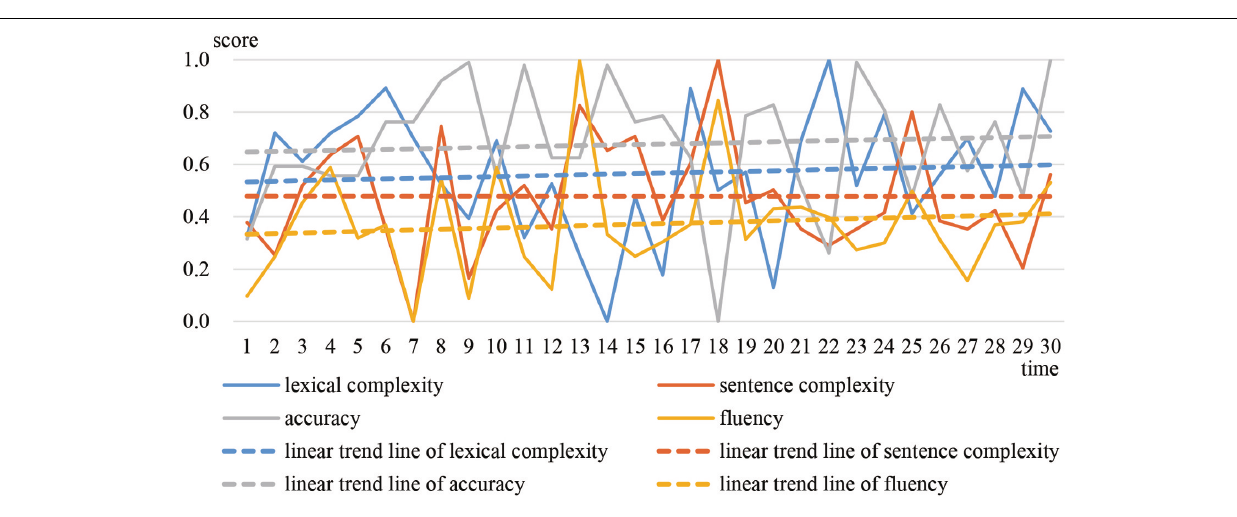
FIGURE 4 | Developmental trajectories and trends of Greg’s